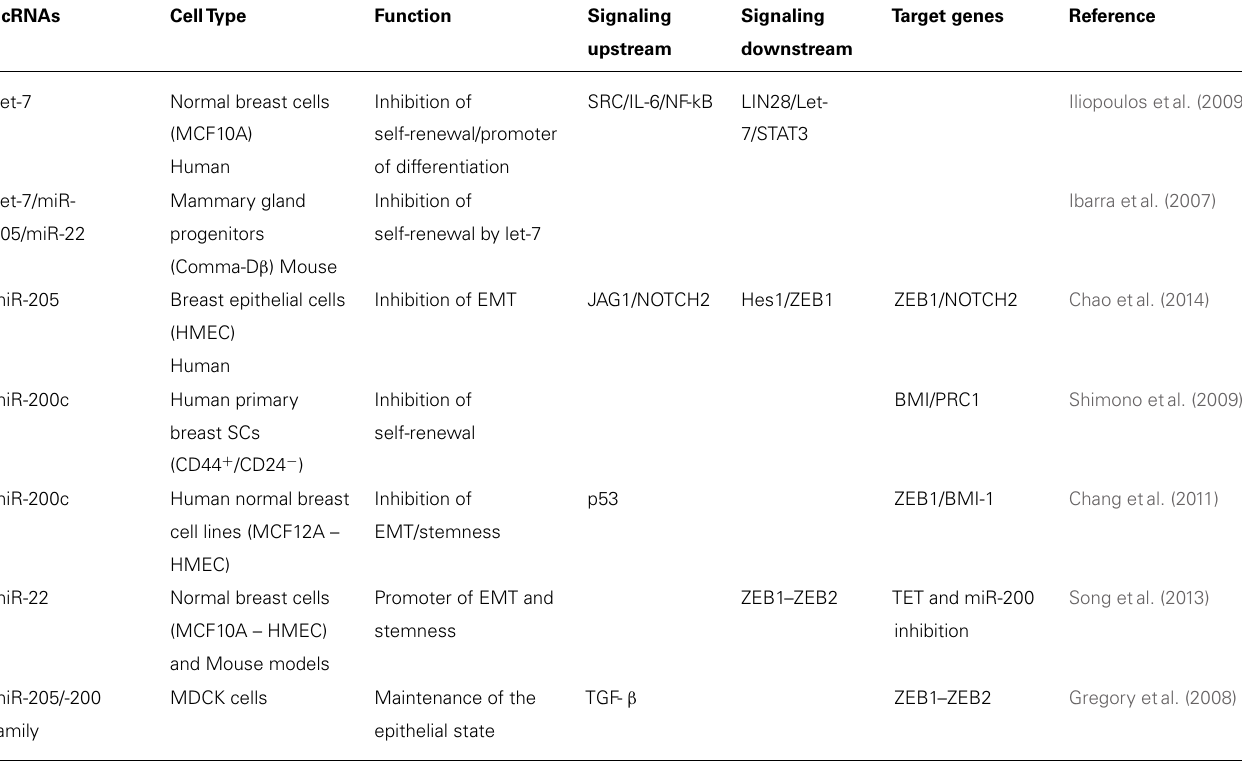
Table 1 | List of microRNAs (miRNAs) and long ncRNAs (lncRNAs) associated with normal breast stem cells (SCs).